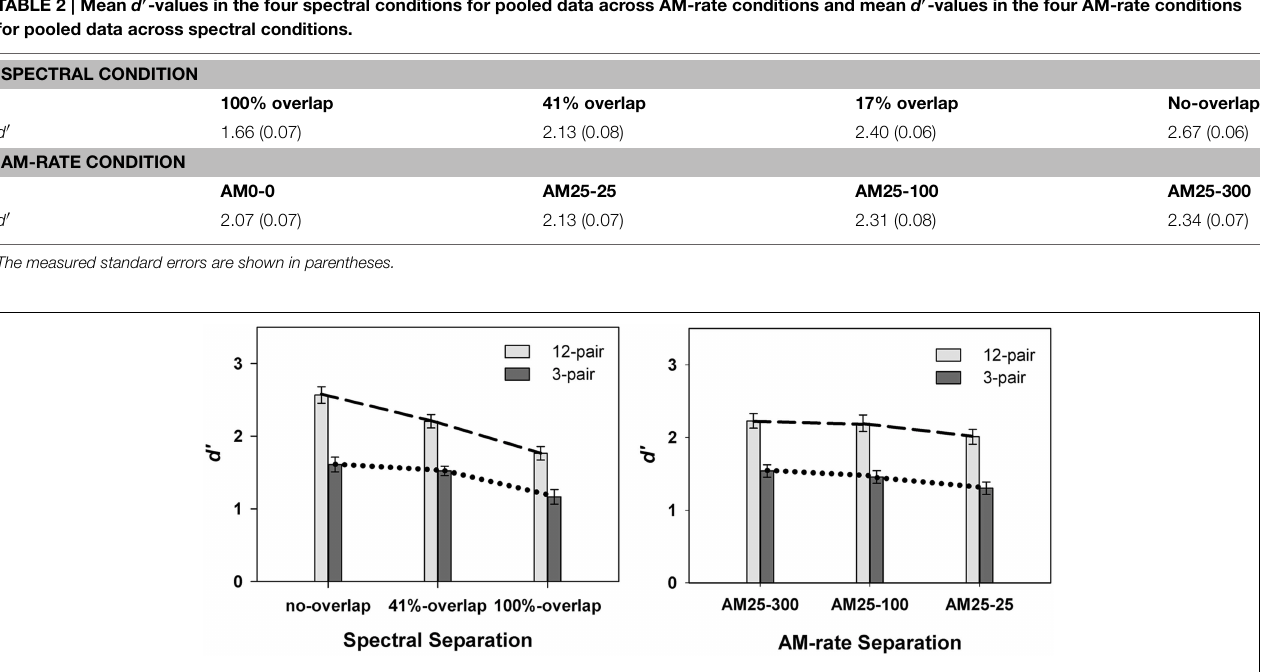
FIGURE 3 | Contrasts of mean d ′ -values in Experiment 1 between 12-pair and 3-pair stimulus sequences for the three spectral separations (left panel) and for the three AM-rate separations (right